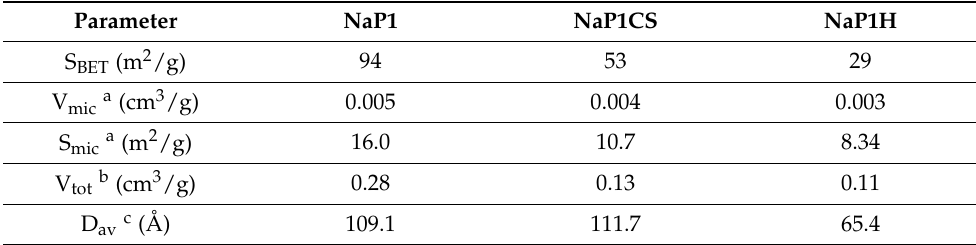
Table 2. Surface characteristics of NaP1CS.